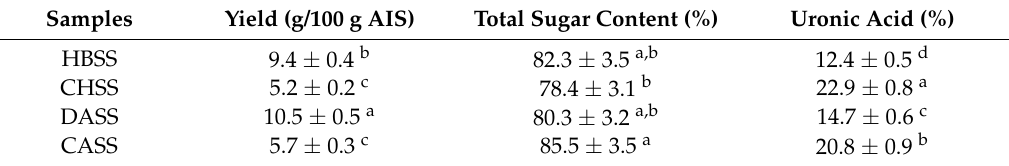
Table 1. Yield, sugar composition, and uronic acid content of MLPs. Values were expressed as mean ± SD of three replicates, with different letters indicating significant differences at level of p < 0.05. HBSS: Hot buffer; CHSS: Chelating agent; DASS: Dilute alkali; CASS: Concentrated alkali.